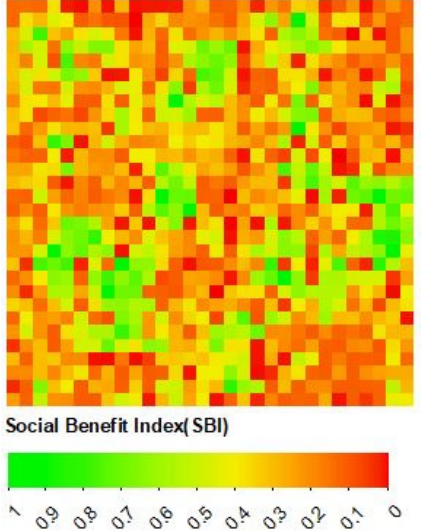
Figure 6. Value of SBI of each cell for the hypothetical dataset.